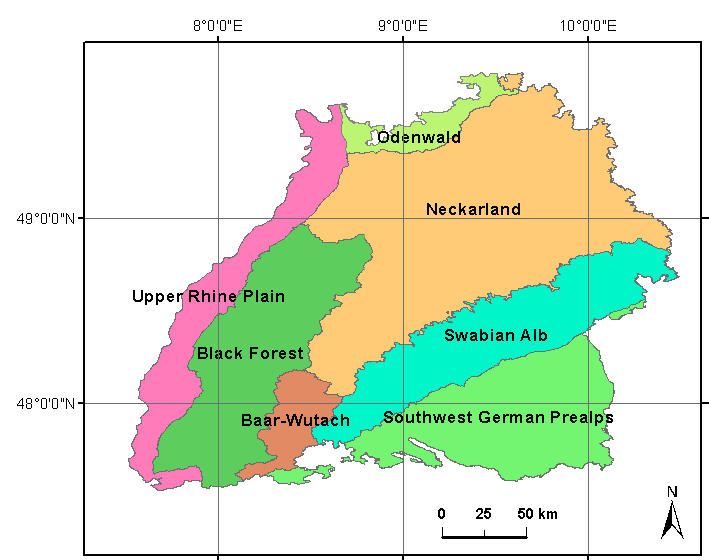
Figure 1. Main growing regions of Baden-Württemberg.